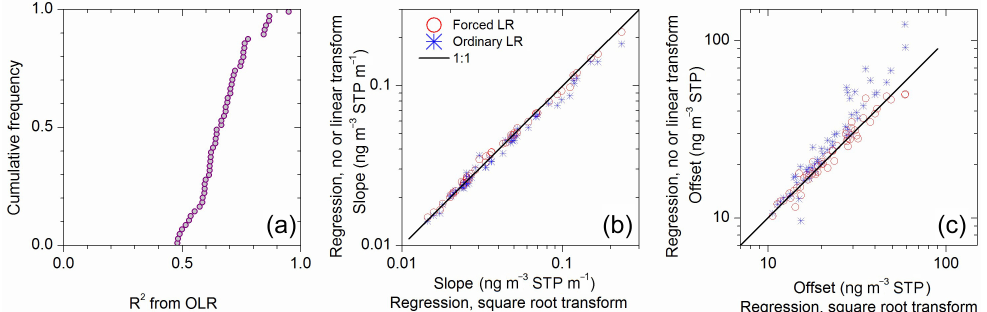
Figure 2. (a) Cumulative frequency of the coefficient of determination ( R 2 ) of ordinary linear regression (OLR) between particulate sulfur concentration and distance from the tropopause of the 52 data groups used in this study. (b, c) Comparison of slope (Fig. 2b) and offset (c) between a square root transformed dependent variable and both OLR and forced linear regression.